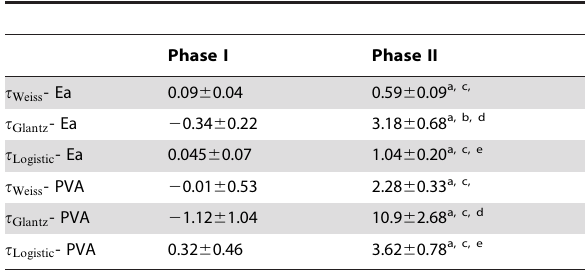
Table 1. Coefficients from regression of t versus Ea or PVA